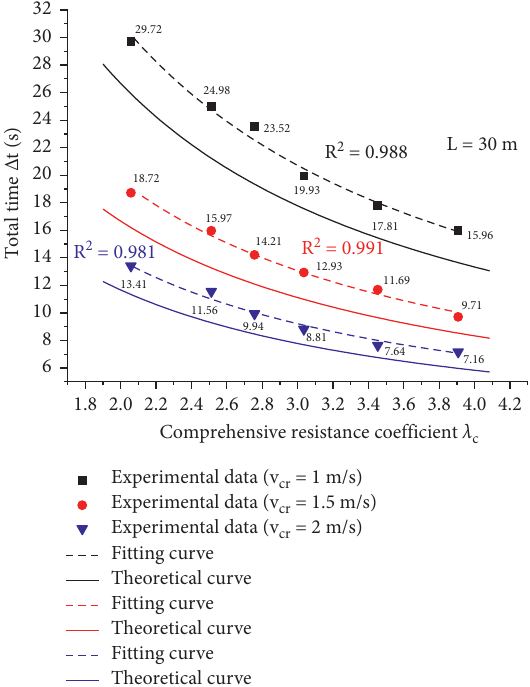
Figure 9: L � 30 m, the total time under different λ